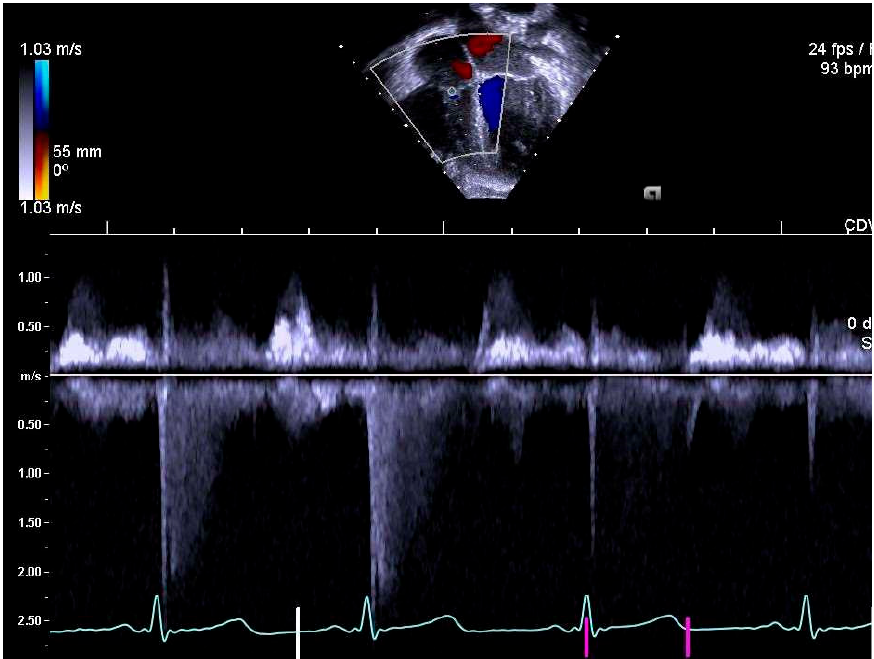
Figure 2. Tricuspid regurgitation (TR) measured by continuous wave Doppler.